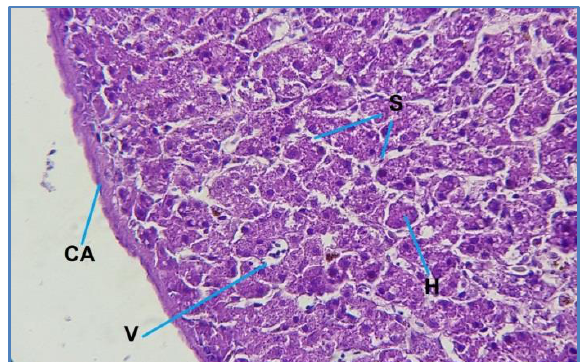
Figure, 8: Histological section of the liver in gull shows, the central vein (CV), hepatocyte plates (HP), sinusoids (S) Portal